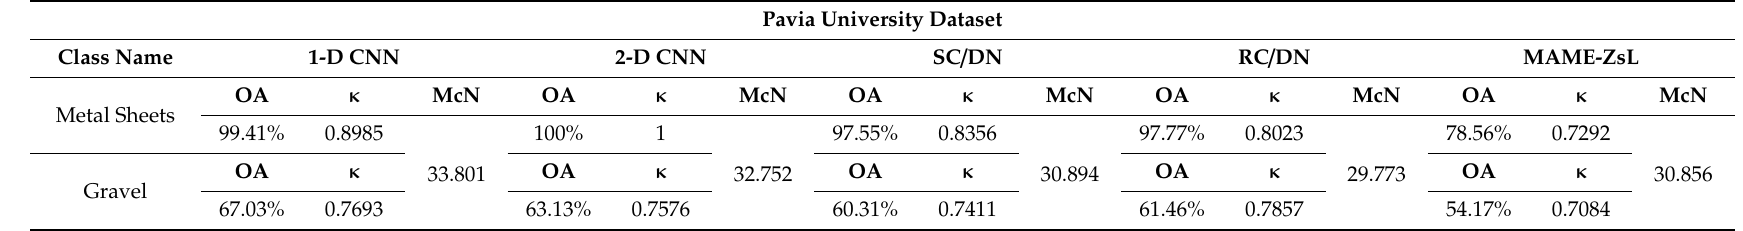
Table 5. Testing classification accuracy and performance metrics.